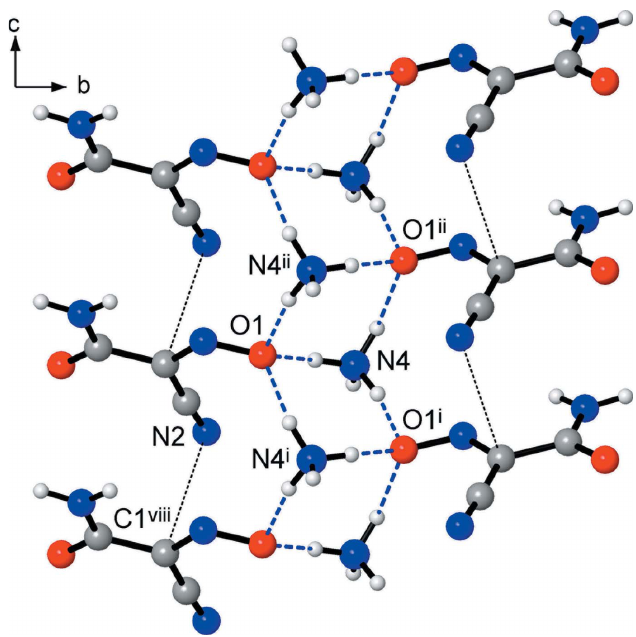
Figure 2 Fragment of the crystal structure showing chains, propagating down the c - axis direction, of ammonium/nitroso rhombs sharing opposite edges [symmetry codes: (i) (cid:3) x , (cid:3) y , z (cid:3) 1